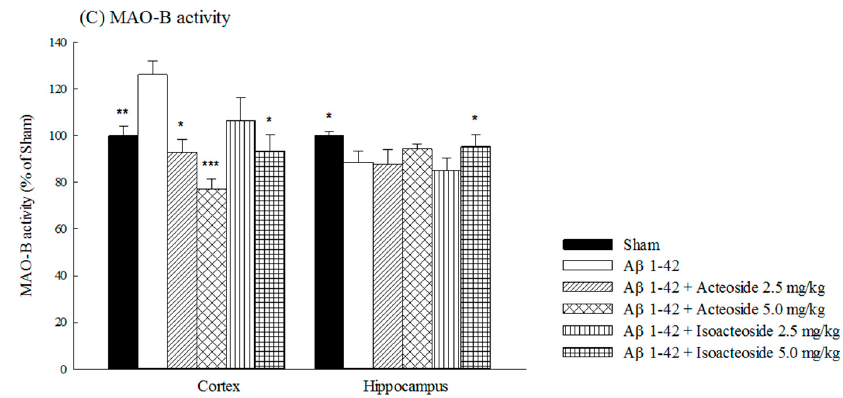
Figure 6. Effects of acteoside or isoacteoside (2.5, 5.0 mg/kg; po) on: ( A ) AChE; ( B ) MAO-A; and ( C ) MAO-B activities in cortex and hippocampus of A β 1-42-infused rats. Acteoside or isoacteoside was continuously administered after A β 1-42 infusion until all rats were sacrificed. Columns indicate mean ± SEM ( n = 6). * p < 0.05, ** p < 0.01, *** p < 0.001 compared with A β 1-42-infused rats. Table 1. Effects of acteoside and isoacteoside (2.5, 5.0 mg/kg; po) on the levels of cortical and hippocampal neurotransmitters and their metabolites in A β 1-42-infused rats. The Levels of Cortical Neurotransmitters and Their Metabolites (ng/g Protein) - MHPG NE DOPAC HVA DA